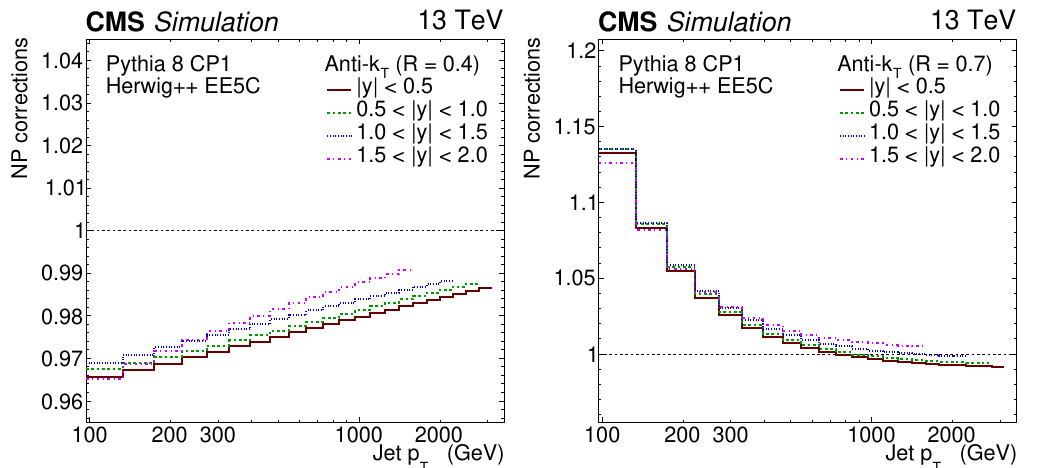
Figure 5 . The values for NP corrections for inclusive jet cross sections. The values for jets with R = 0 . 4 (0.7) are shown on the left (right); each curve corresponds to a rapidity bin. The values correspond to the average of the corrections obtained with pythia 8 and with herwig++